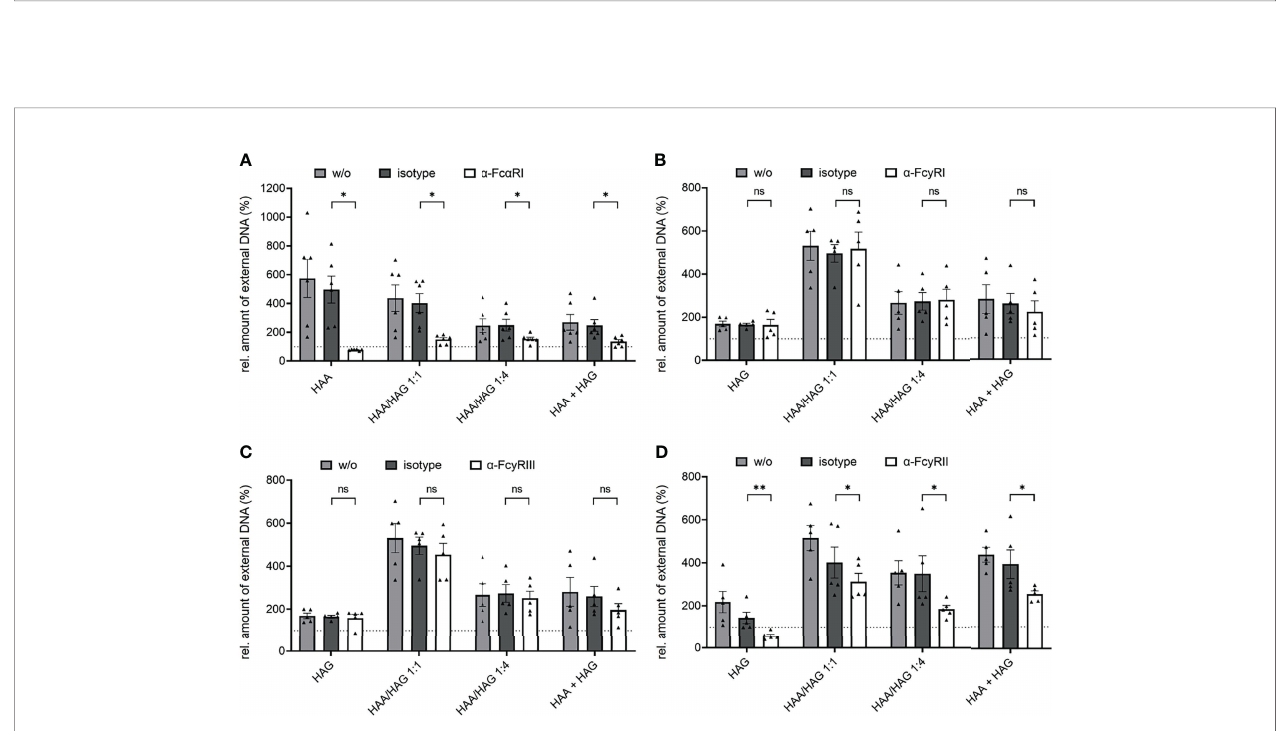
FIGURE 3 | IgA and IgG complex-induced NET formation is dependent on Fc a RI and Fc g RII, respectively. Isolated human neutrophils were stimulated with 150 µg/ ml heat-aggregated IgA (HAA), heat-aggregated IgG (HAG), IgA/IgG mixed complexes in different ratios (HAA/HAG 1:1 or 1:4) or 75 µg/ml heat-aggregated IgA plus 75 µg/ml heat-aggregated IgG (HAA + HAG) in the presence of 10 µg/ml blocking antibodies against Fc a RI (A) , Fc g RI (B) , Fc g RIII (C) , Fc g RII (D) or the respective isotype control. w/o = no additional antibody. Shown are relative amounts of extracellular DNA 270 min after stimulation normalized on HSA treatment. (A) N = 4 donors. (B – D) N = 5 donors. Data are presented as scatter plots with bars showing mean and SEM. The dashed line represents the relative amount of NETs of the HSA treated control. Signi fi cances between isotype and blocking antibody treatment was tested with Wilcoxon matched-pairs signed rank test (A – C) or paired t-test (D) . *p < 0.05 and **p < 0.01. ns, not signi fi cant.